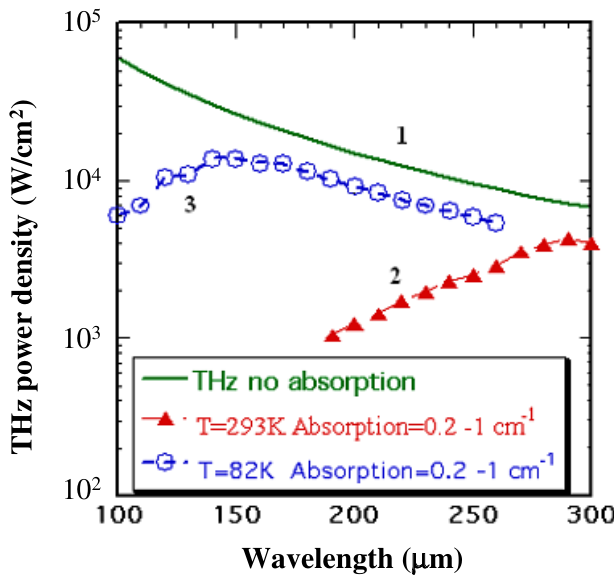
FIG. 8. (Color) THz seed generation in GaAs via difference frequency mixing (1) with no absorption for THz wavelengths, (2) with absorption at a room temperature, and (3) with absorp- tion at a cryogenic